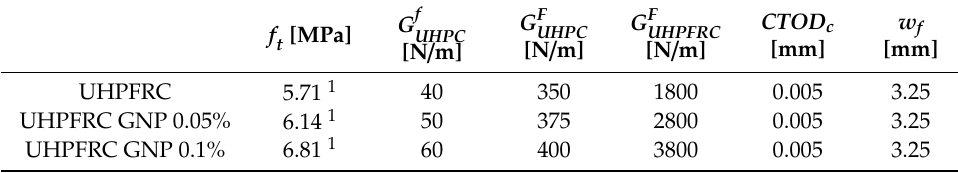
Table 2. Inelastic parameters of embedded cohesive interfaces for the three UHPFRC mixtures.